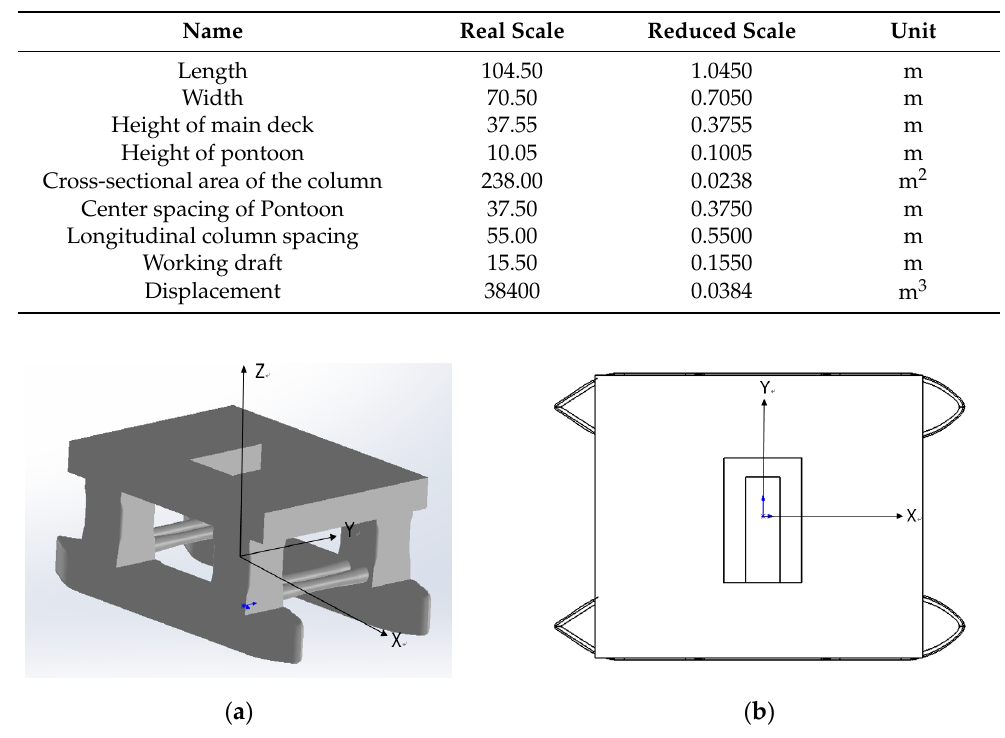
Table 1. Prototype and model values of platform parameters.